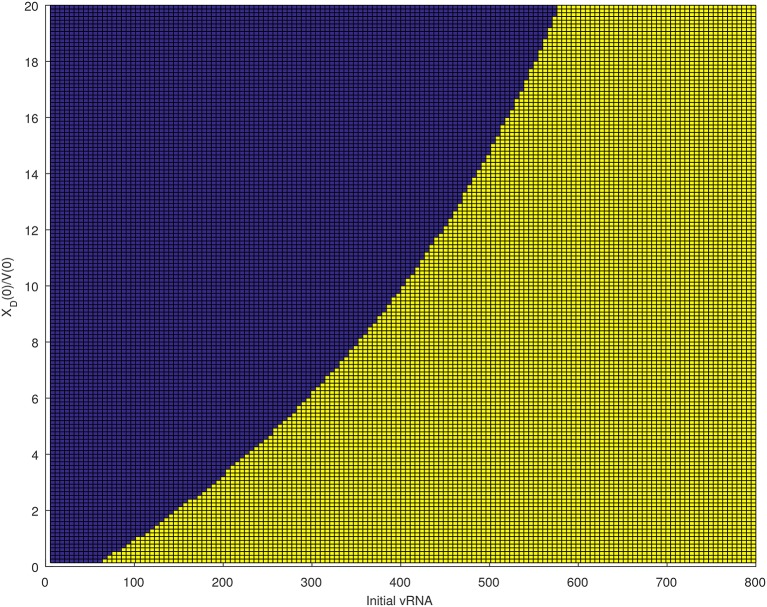
Asymptotic behavior for the VT solutions of (6) for median parameters in Table 3 as the initial vRNA and XD(0)/V(0) are varied. The blue region (left of the curve) corresponds to extinction asymptotic concentrations VT = 0 copies per ml. The yellow region (right of the curve) corresponds to persistence asymptotic concentrations VT=6.9×106 copies per ml.